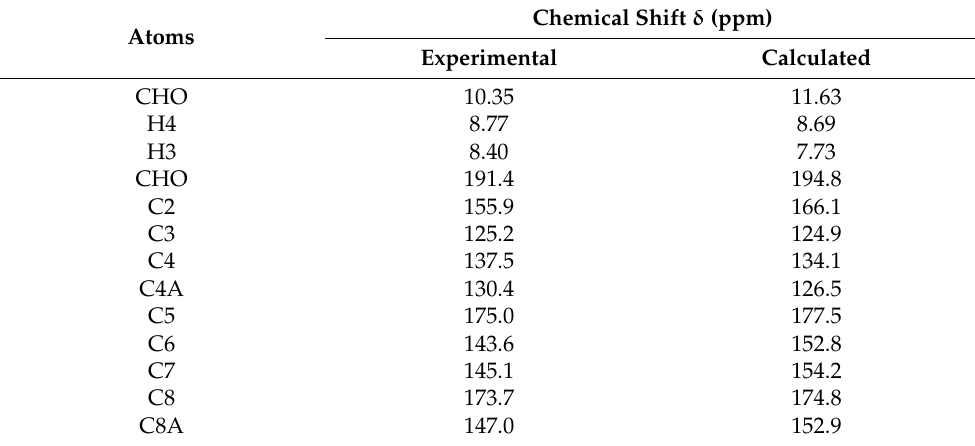
Table 2. The experimental and calculated 1 H NMR and 13 C NMR spectra of derivative 3